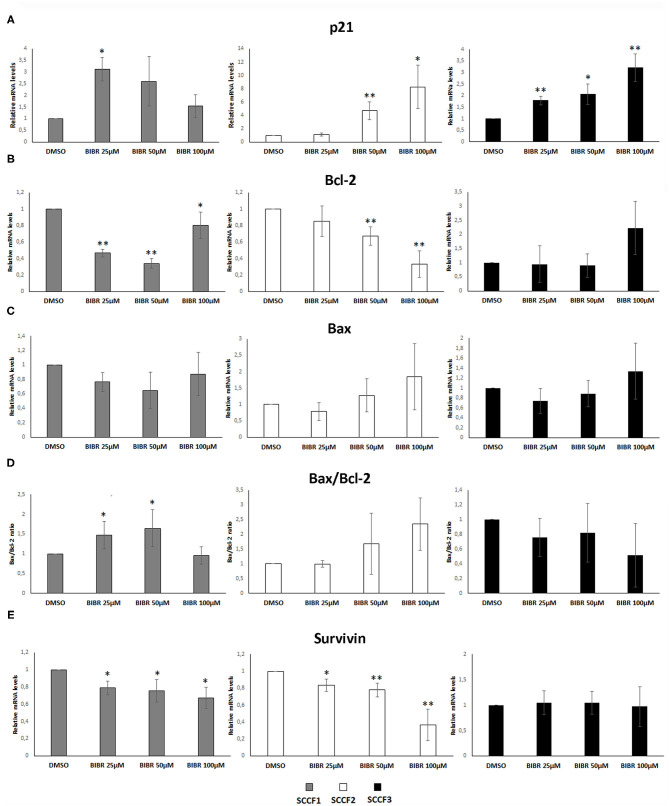
Gene expression changes in p21, Bcl-2, Bax, and Survivin in FOSCC cell lines treated with BIBR1532. SCCF1, SCCF2, and SCCF3 were treated with BIBR1532 at 25, 50, and 100 μM vs DMSO and analyzed by qPCR for p21 (A), Bcl-2 (B), and Bax (C). Bax/Bcl-2 transcriptional ratio (D) and Survivin gene expression (E) were also calculated as a measure of activated apoptosis. Data were normalized for β2-microglobulin and expressed as relative quantization by the 2−ΔΔCt method. Changes in relative mRNA levels for each dose of BIBR1532 were calculated and compared with their respective DMSO control set as 1. Plots represent the mean ± standard deviations of at least three repeated, independent experiments performed in technical triplicate (statistically significant, *P < 0.05; **P < 0.01).